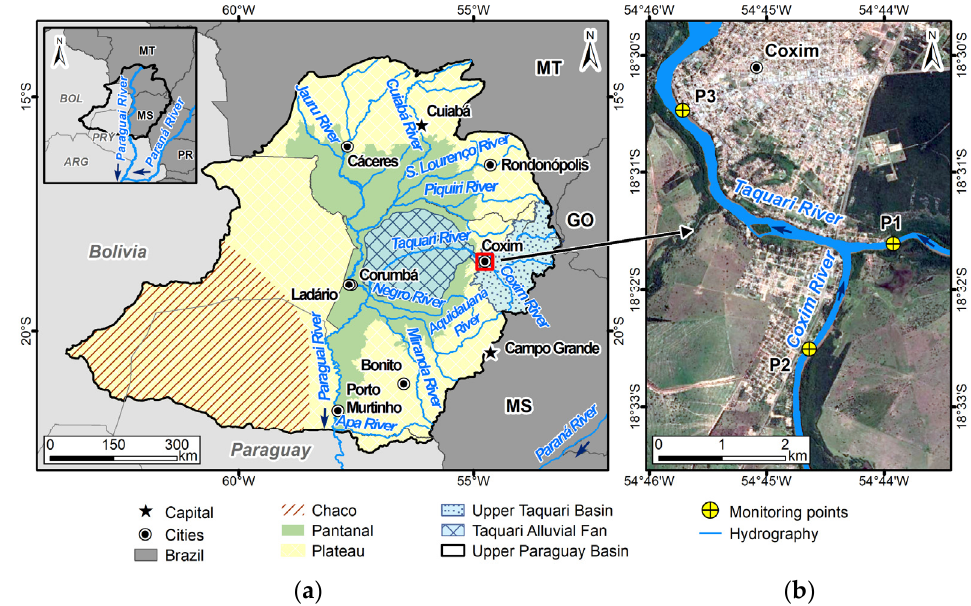
Figure 1. ( a ) Upper Paraguay Basin, Pantanal wetland and study site at Taquari River in Coxim, Brazil; ( b ) points of measurement in Coxim: P1 and P3 at Taquari River, P2 at Coxim River.